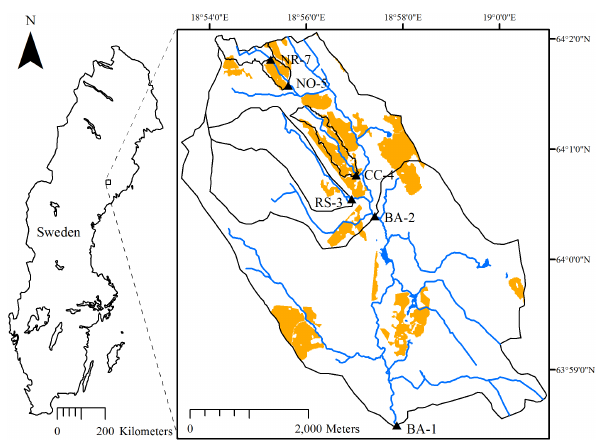
Figure 1. The Balsjö paired catchment experiment including the catchments RS-3, CC-4, NO-5, and NR-7, as well as the two down- stream sites BA-2 and BA-1 that integrate the larger 22.9km 2 Bal- sjö Stream Network. Areas harvested during 2001–2011 are shown as orange. Solid blue lines represent the stream network; solid blue areas show ponds with open water. Solid black lines indicate the catchment boundaries, black pyramids the location of water sam-